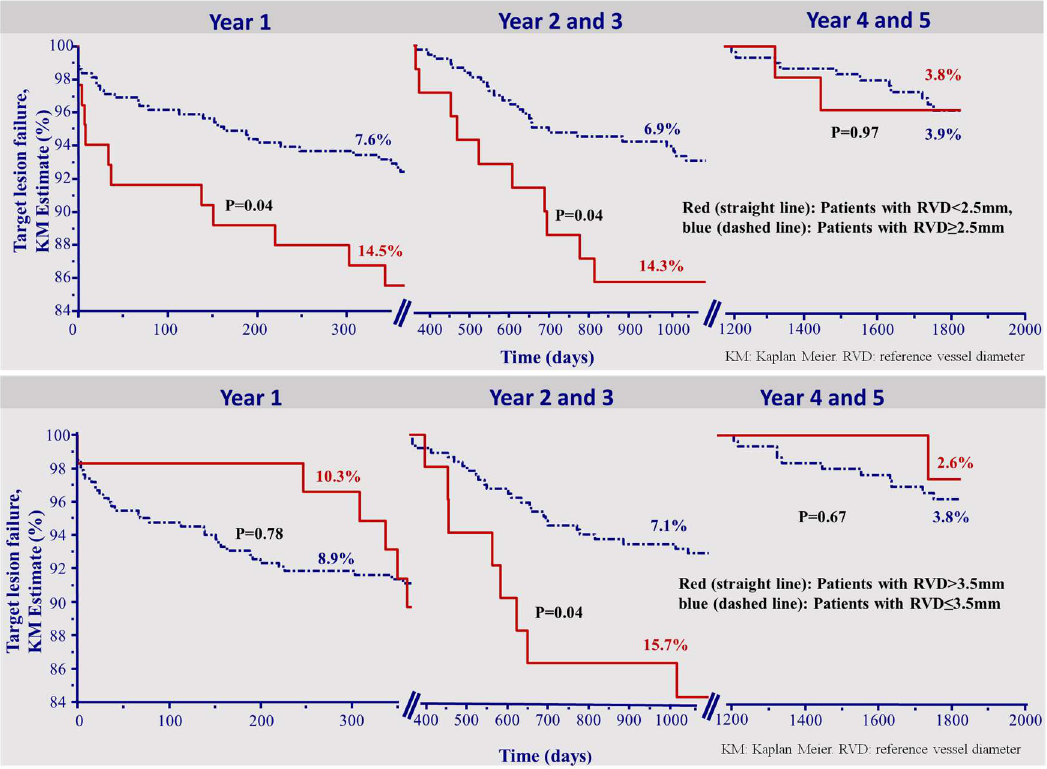
Figure 2. Kapla–Meier survival curve for the incidence of target lesion failure. The incidence of target lesion failure was higher in small vessels (RVD < 2.5 mm) up to 3 years, but not thereafter (upper panel). Finally, the incidence of TLF was initially ( < 1 year) and then higher (2–3 years) in vessels larger than 3.5 mm. After 3 years, this parameter had no impact (lower panel). KM: Kaplan–Meier. RVD: reference vessel diameter.